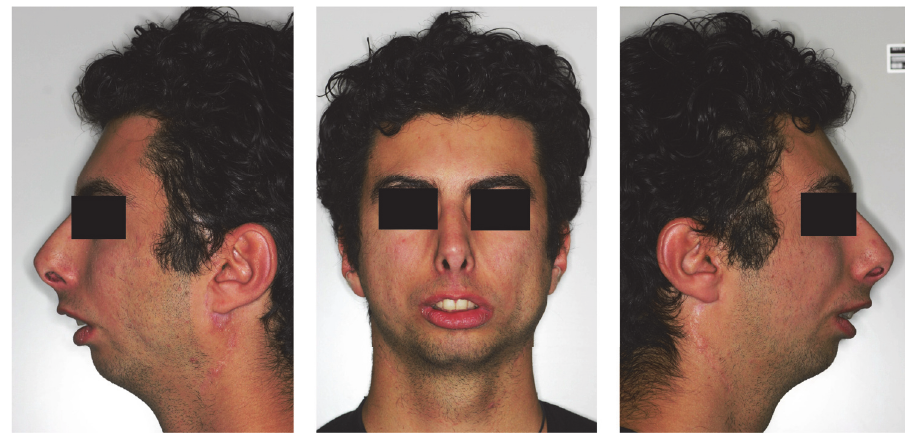
Figure 1: Extraoral pictures of profile before